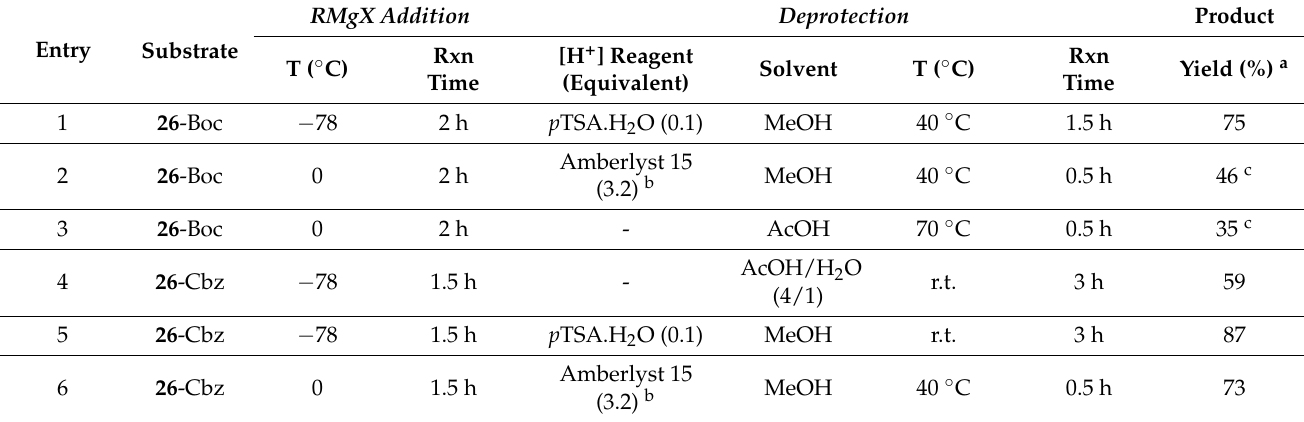
Table 1. Optimisation of the RMgX addition and deprotection reaction sequence in batch.